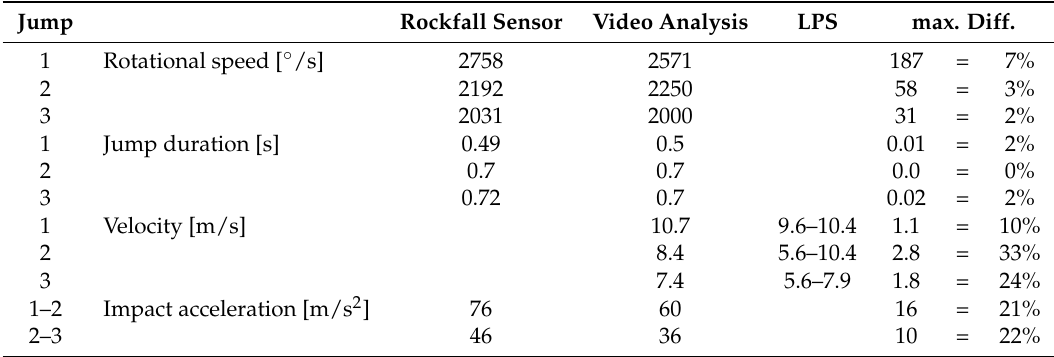
Table 5. Comparison of single results of redundant measurements during Test 109 during three jumps in the runout zone between 15s and 17s. The comparison between the two different measurements is given by the absolute difference and the percentage with respect to the measured/derived value, which was considered to be more